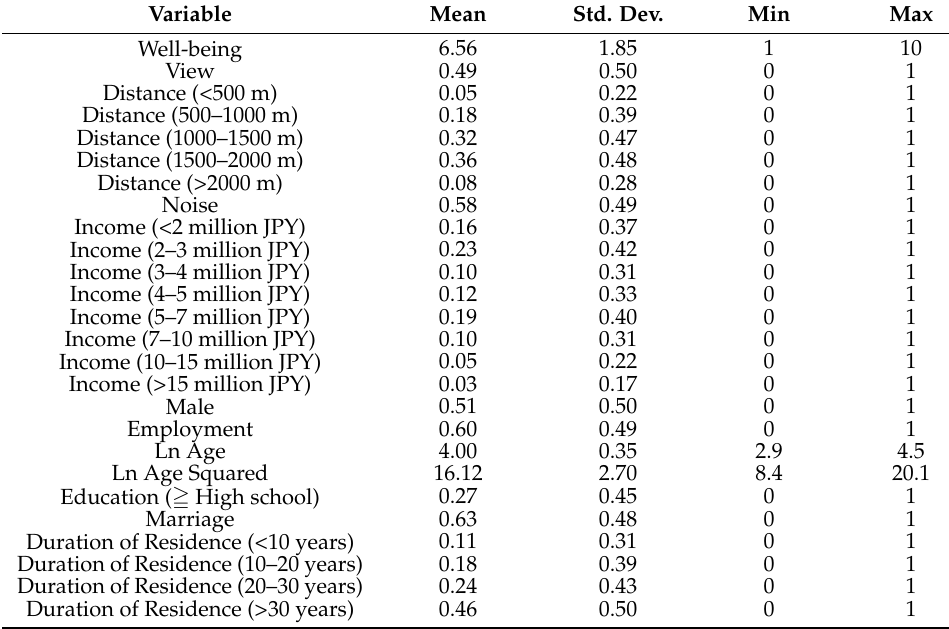
Table 1. Descriptive statistics (N = 201